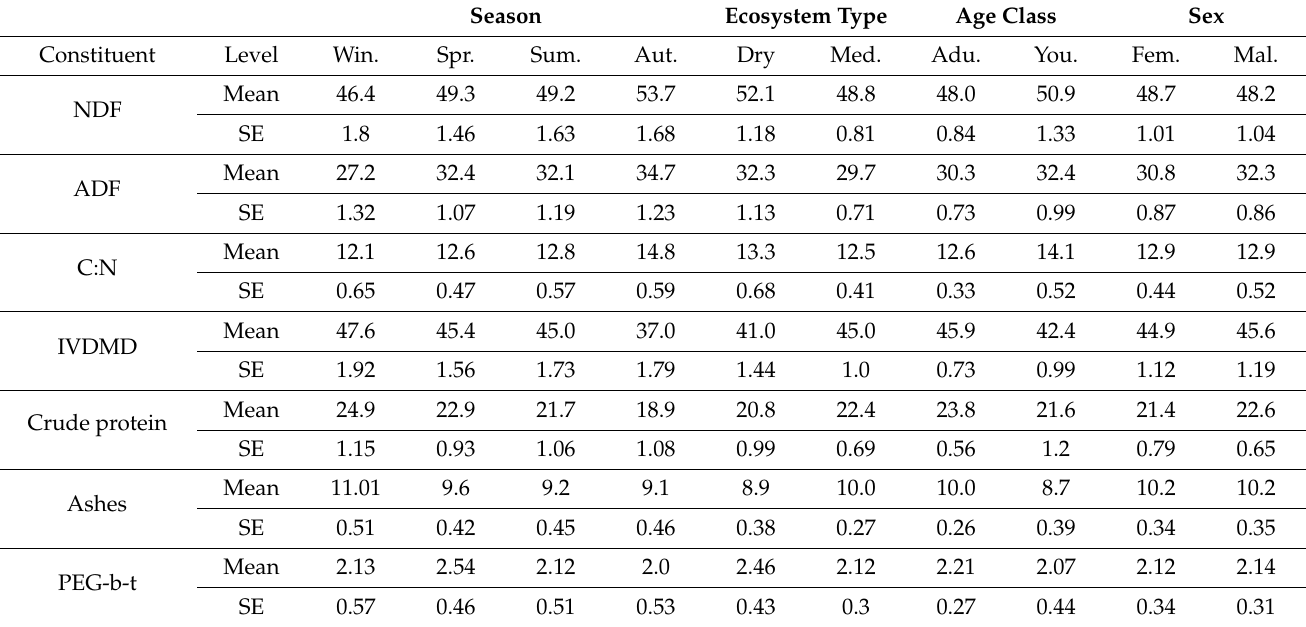
Table 6. Means ± standard errors (SE) of the different nutritional constituents, as predicted using NIRS, according to season (Aut., Win., Spr., Sum., for autumn, winter, spring, and summer, respectively), ecosystem type (Dry, and Med. for Mediterranean), age-class (Adu., You., for adult and young, respectively), and sex (Fem., Mal., for female and male, respectively). Values may differ slightly from Figure 5, as the table presents raw